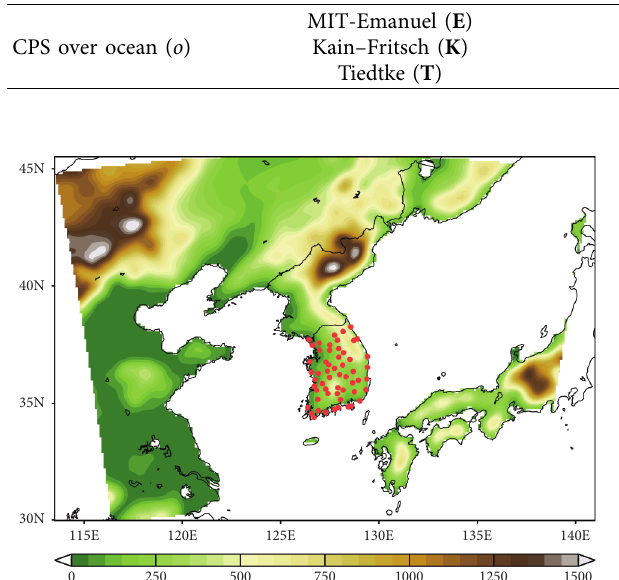
Figure 1: Domain and topography (m) for the simulations, and location of 56 observation stations over South Korea (red